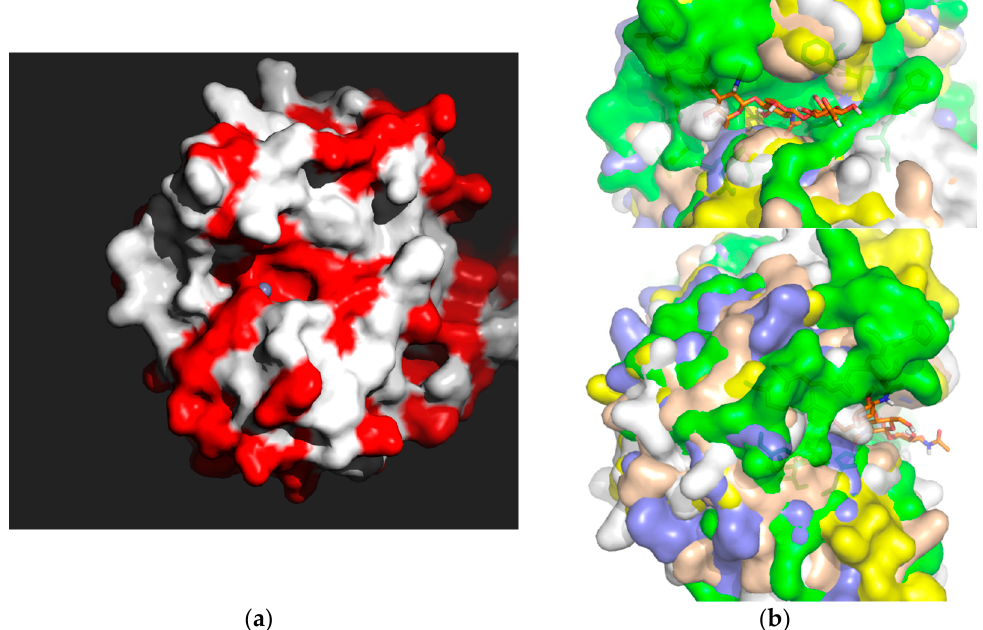
Figure 7. Conservation of NodB binding sites. ( a ). Surface representation of the NodB PDA binding domain facing the active site with the Group 1 amino acid residue identity (in red) for Ba0331, Ba0330 and Bc0361. The metal (Zn) ion position in the active site is indicated with a grey sphere. ( b ). Surface representation of the NodB PDA binding site from selective B. anthracis and B. cereus structurally determined NodB domains superimposed (Bc1974 (yellow), Ba0331 (blue), Ba0330 (green), Bc1960 (beige), Ba0424 (white)) in two orthogonal views to highlight the similarities (shape) and detailed differences between the PDAs. A trisaccharide GlcNAc is modelled in Bc1974 (in orange sticks) [35]. The formation of the binding crevice (running horizontally) is shown as well as the detailed differences between the PDAs on the surface.